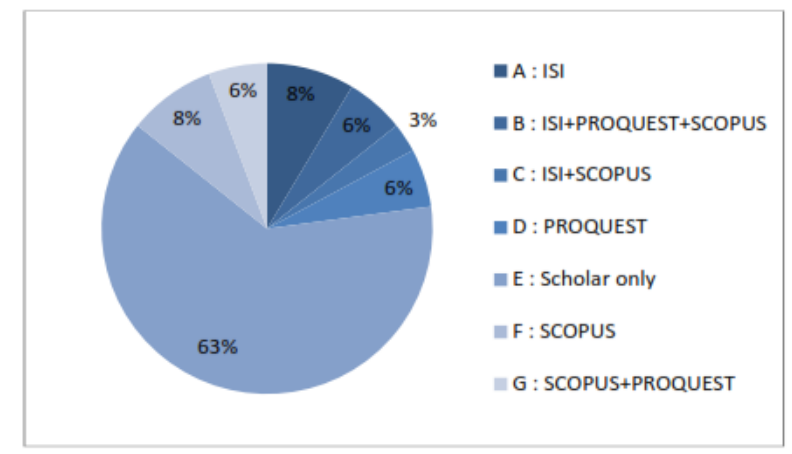
Fig. 2. Distribution of publications per origin.